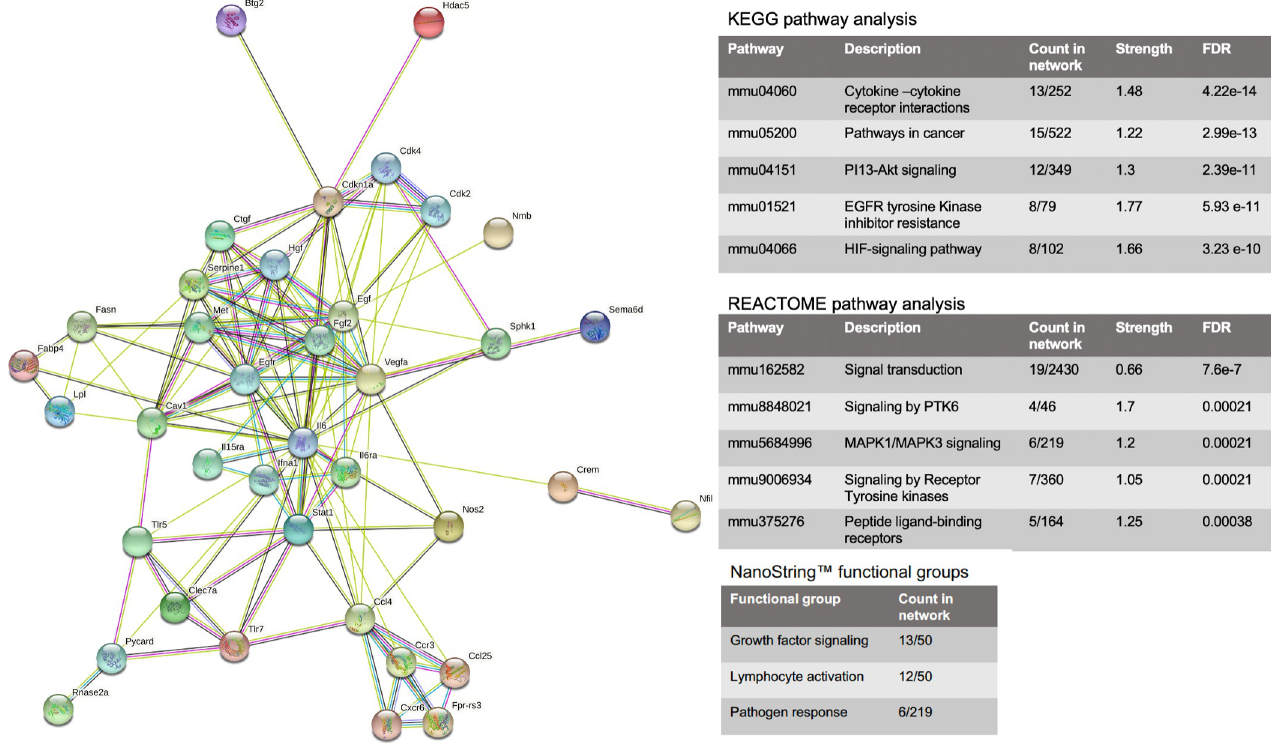
Fig 7. Protein-protein interaction network. PPI network was generated using the top hits of both joint and muscle tissues combined. The cut off criteria included at least a 1.3 FC and a � P value < 0.02. Circles represent genes and lines represent the interaction of proteins between genes. Line colour represents evidence of interaction between the proteins. Top hits were selected based on lowest FDR. Results for both KEGG and REACTOME pathways are shown. Top three functional groups as identified with NanoString ™ annotations are also shown.